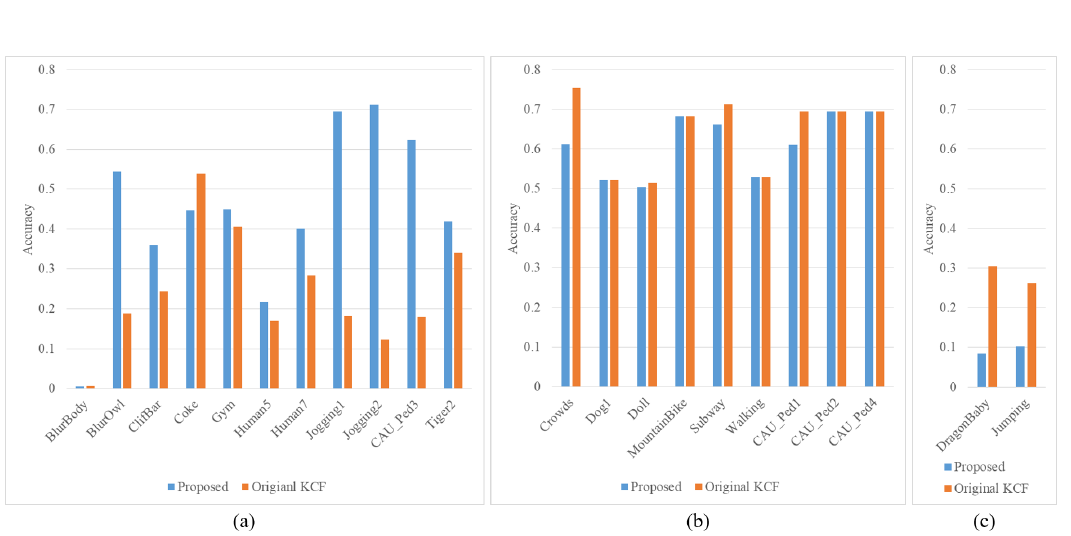
Figure 11. Accuracy comparison between the proposed method and original KCF